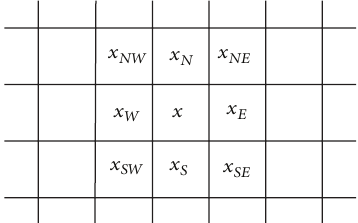
Figure 2: Texture context of the pixel 𝑥 to be